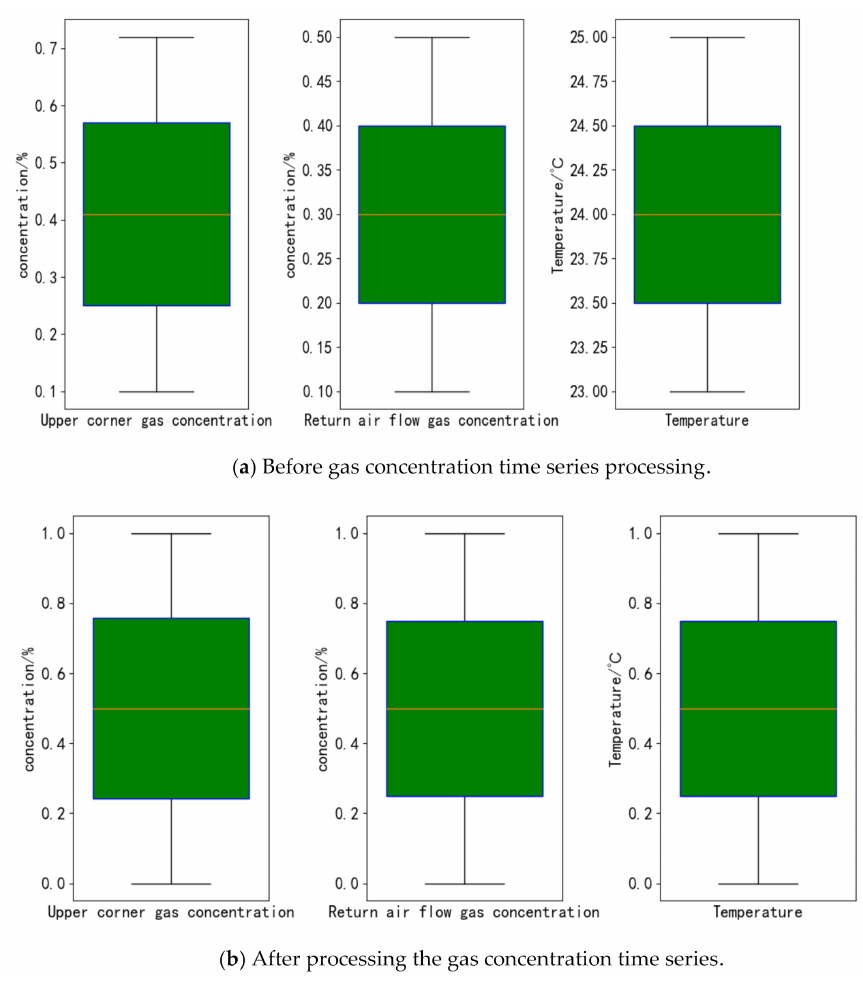
Figure 5. A time series diagram of gas concentration